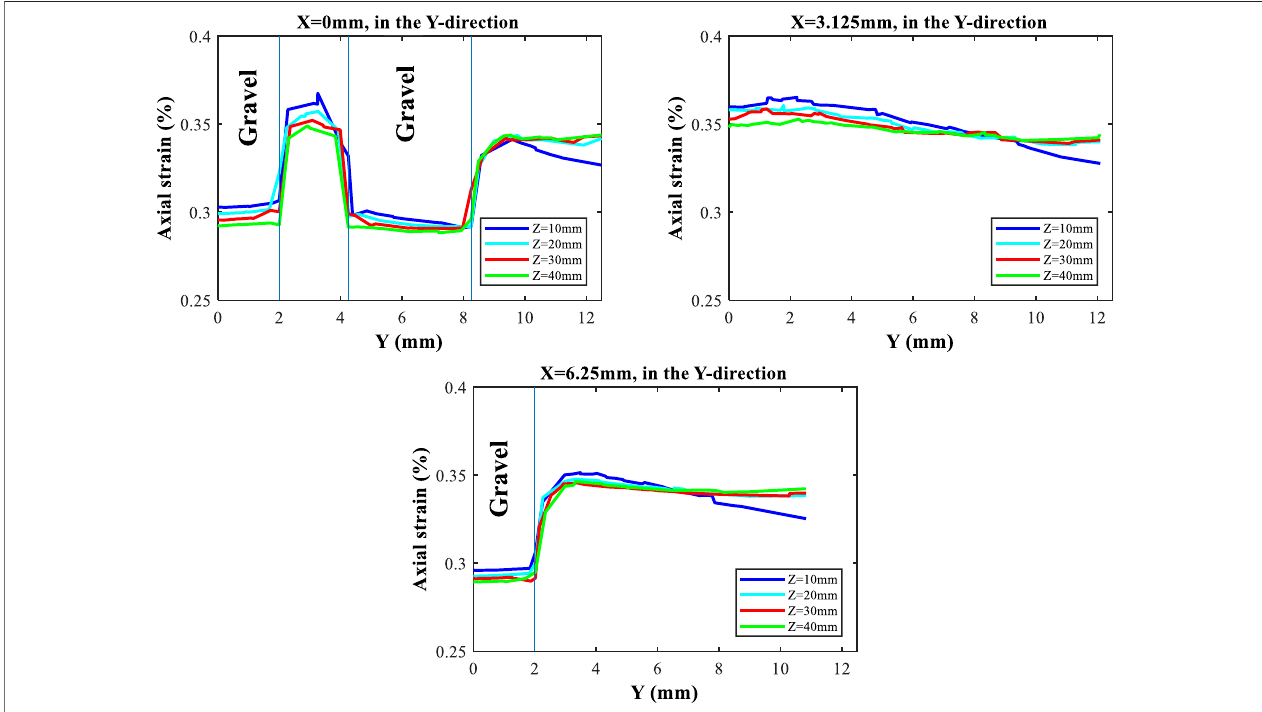
FIGURE9| DistributionofaxialstrainsatX (cid:2) 0,3.125,and6.25 mmintheY-directioninplanesofZ (cid:2) 10,20,30,and40 mminthebasecase.Verticallinesdenote the gravel-matrix